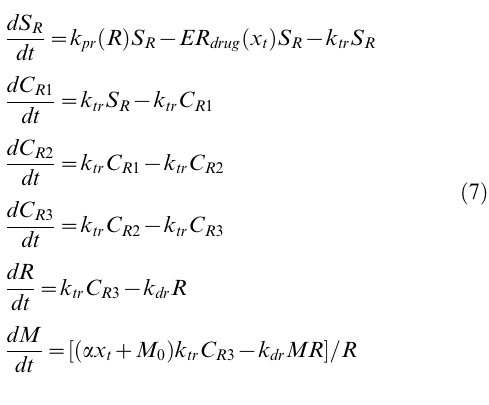
Leukopoiesis Model (Variable for GSA: L